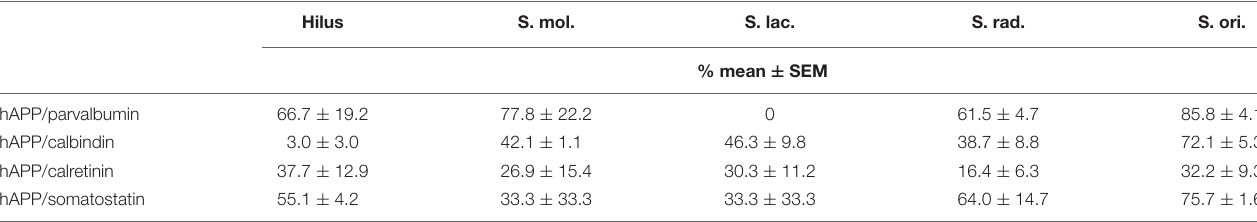
TABLE 2 | Proportions of parvalbumin-, calbindin-, calretinin-, and somatostatin-positive neurons expressing hAPP.